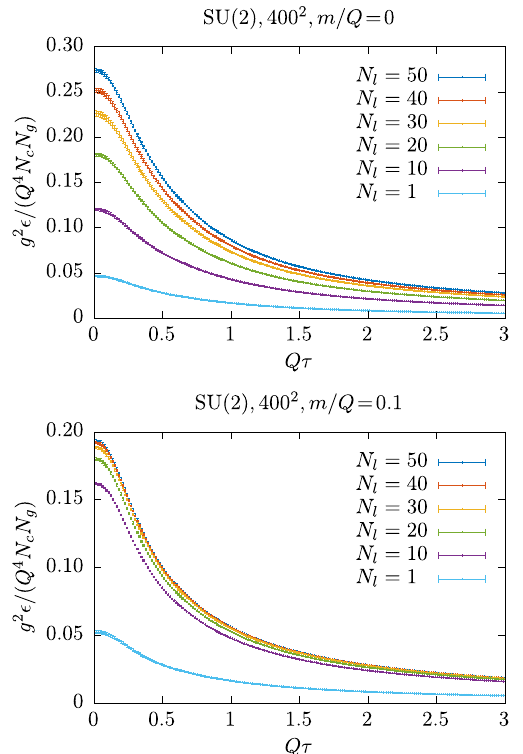
Fig. 4 Totalenergydensityfordifferentnumbersoflongitudinalsheets N l without (top) and with (bottom) an additional IR